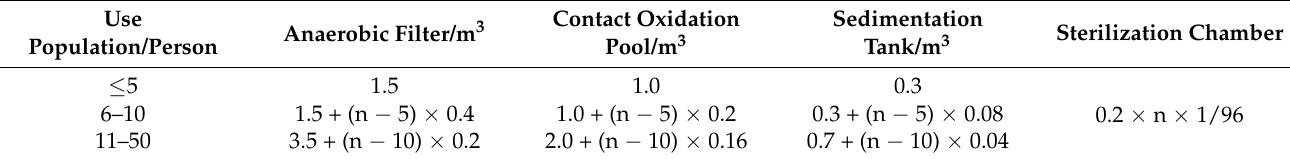
Table 3. Volume of each compartment in the purification tank